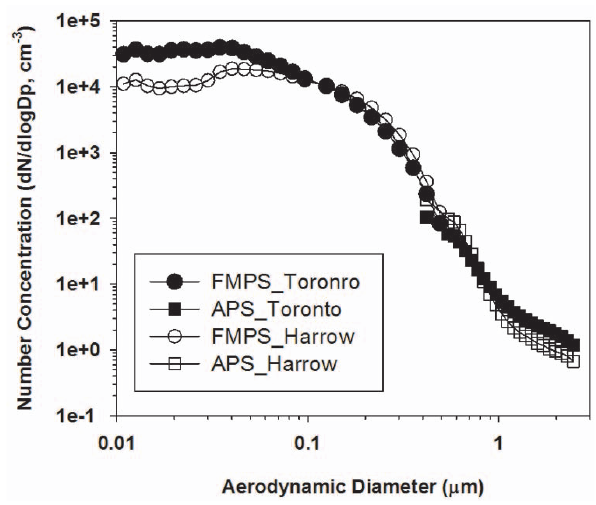
Fig. 2. Average size distributions of particles measured by the FMPS (0.01µm–0.50µm) and the APS (0.30µm–2.50µm) in Toronto and